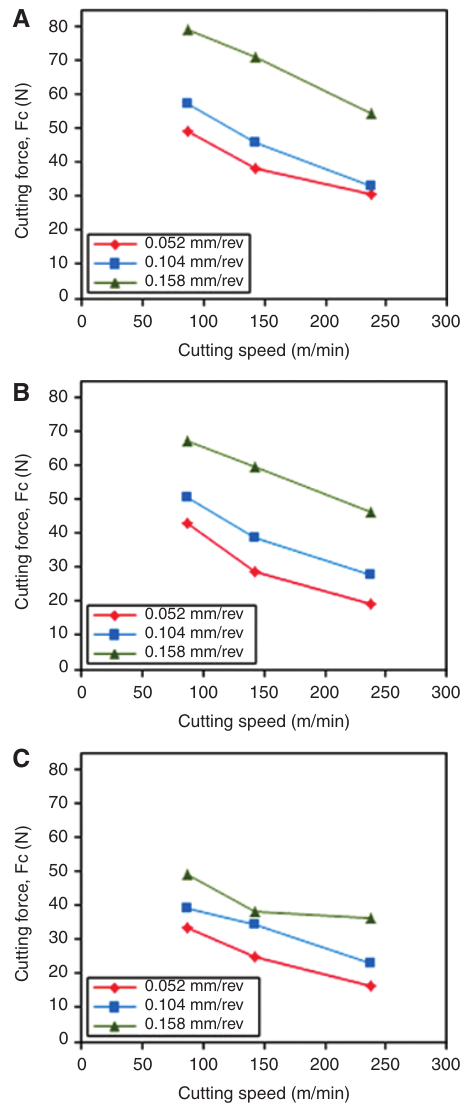
Figure 7 Effect of cutting speed on cutting force for various tool radiuses: (A) r = 0.4 mm, (B) r = 0.8 mm, and (C) r = 1.2